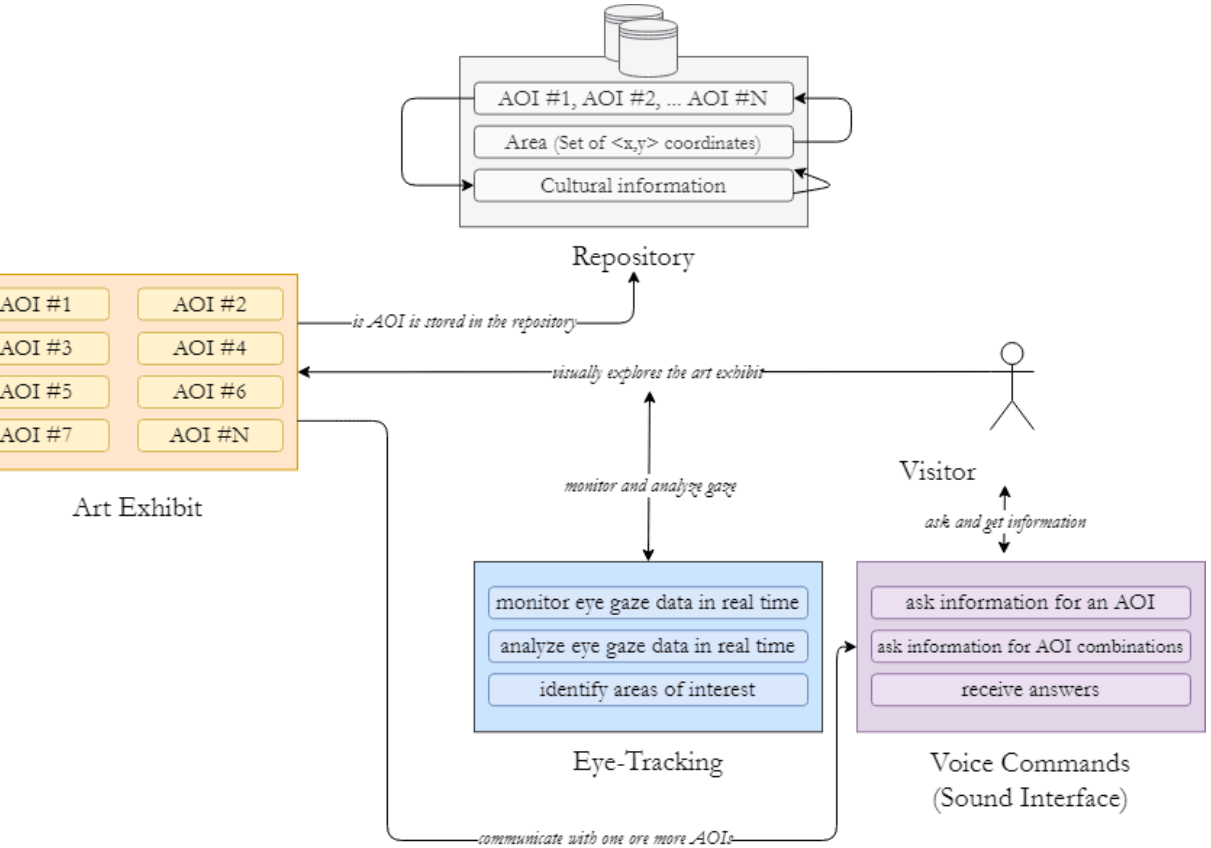
Figure 1. The conceptual architecture of MuMIA (Multimodal Interactions to Better Understand Art